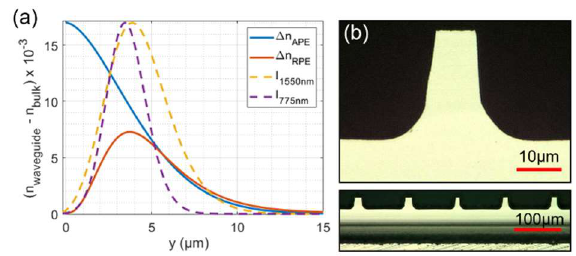
Fig. 1. (a) In-depth RI of measured APE (blue) and calculated RPE (red) planar waveguides at 532 nm. Dashed curves are simulated intensities of the fundamental modes after RPE at 1550 nm (yellow) and at 775 nm (violet). (b) Micro-graphs of the sample’s facet at 500x and 2000x